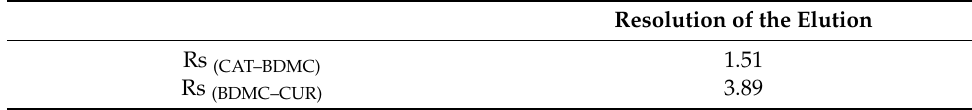
Table 1. Peak resolution of two consecutive curcuminoids peaks.